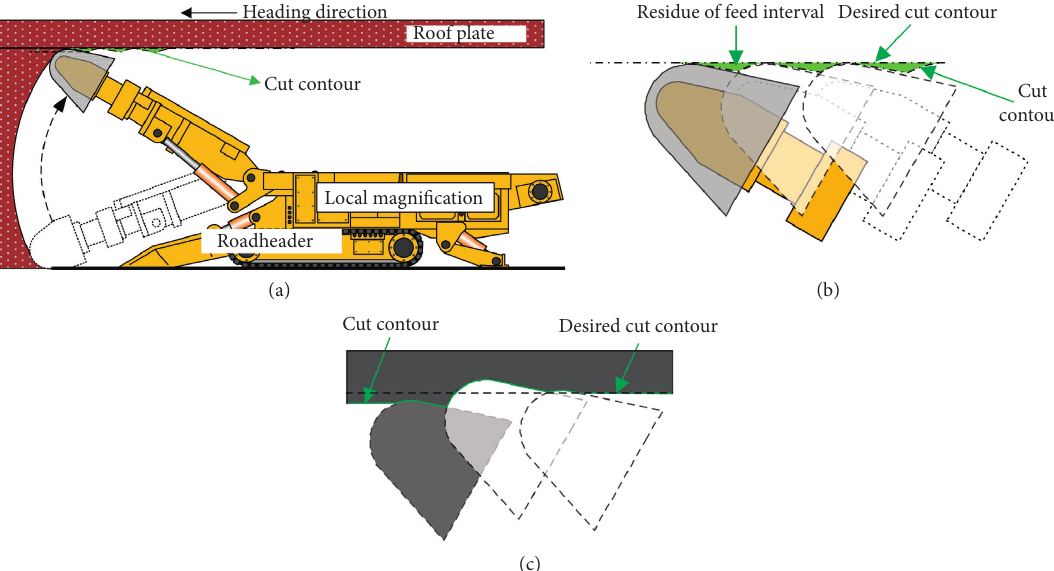
Figure 1: Schematic diagram of roof forming process of driving roadway. (a) Schematic diagram of roadheader work. (b) Cut contour without considering cutting vibration. (c) Cut contour with considering cutting vibration.